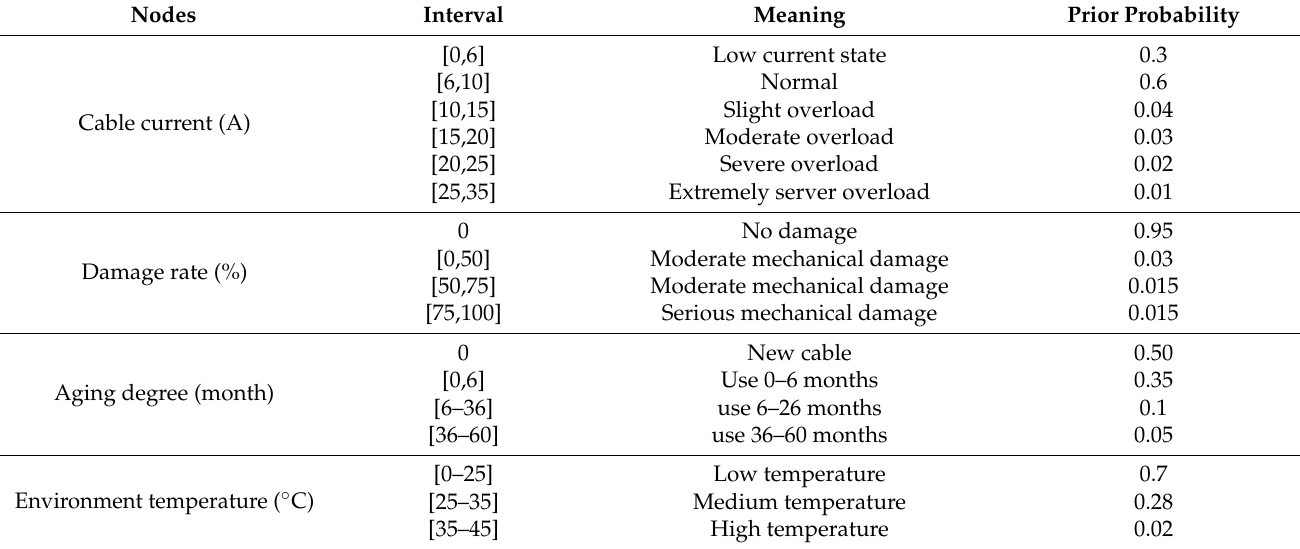
Table 1. Prior probabilities of root nodes.